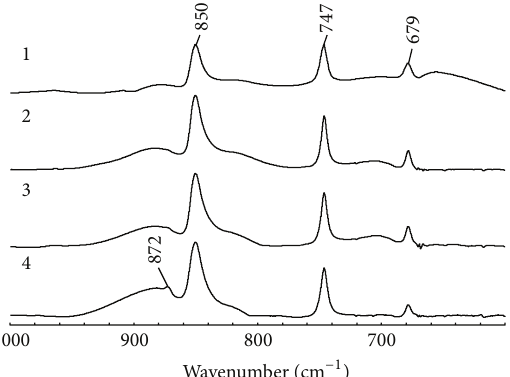
Figure 5: FTIR spectra of La 2 (CO 3 ) 3 ⋅ 8H 2 O (line 1), La 2 (CO 3 ) 3 ⋅ 8H 2 O containing 1wt% La(OH)CO 3 (line 2), La 2 (CO 3 ) 3 ⋅ 8H 2 O containing 2 wt% La(OH)CO 3 (line 3), and La 2 (CO 3 ) 3 ⋅ 8H 2 O containing 5 wt% La(OH)CO 3 (line 4) in the fingerprint region (1000–600cm −1 ).